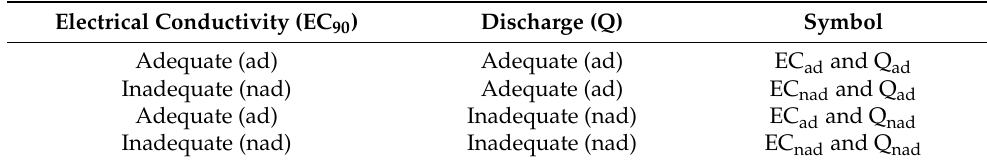
Table 4. Water quality criteria and well